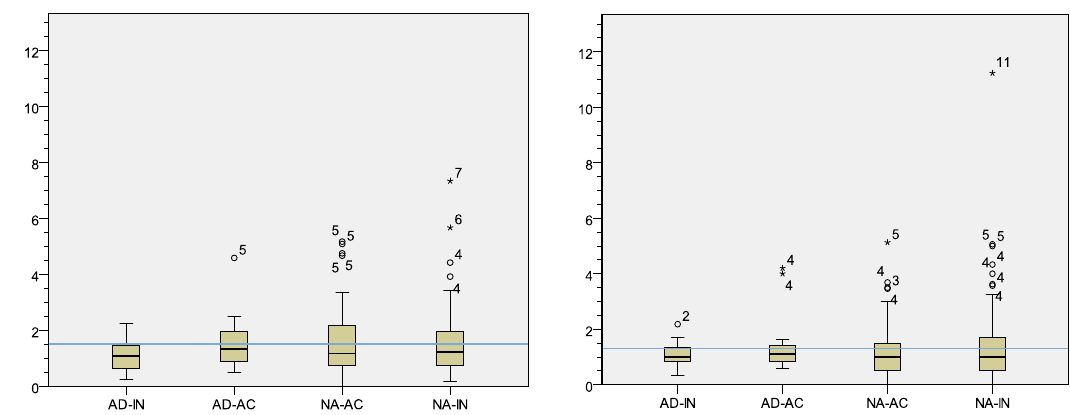
Figure 2. Health-care provider visits per month by intervention groups. Note. Blue lines = mean. AD-IN = adhered and previously inactive, AD-AC = adhered and previously active, NA-AC = non adhered and previously active, NA-IN = non adhered and previously inactive * stands for “Outliers”.